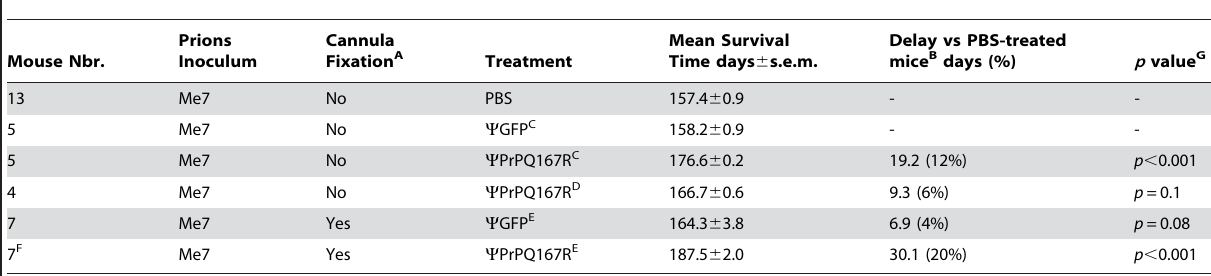
Table 1. Survival time after administration of treatment to mice.